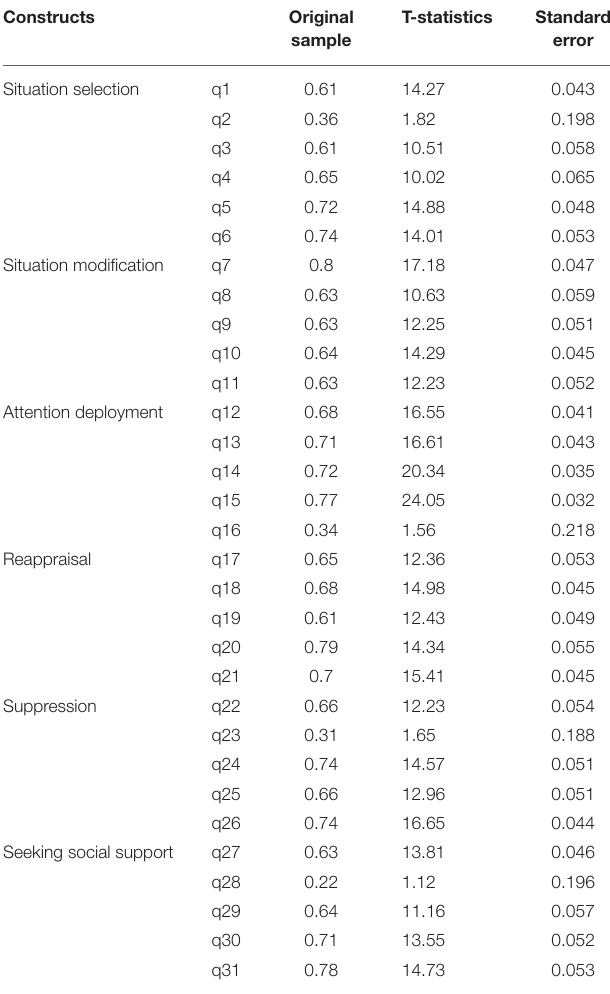
TABLE 5 | The results of confirmatory factor analysis (the first model).